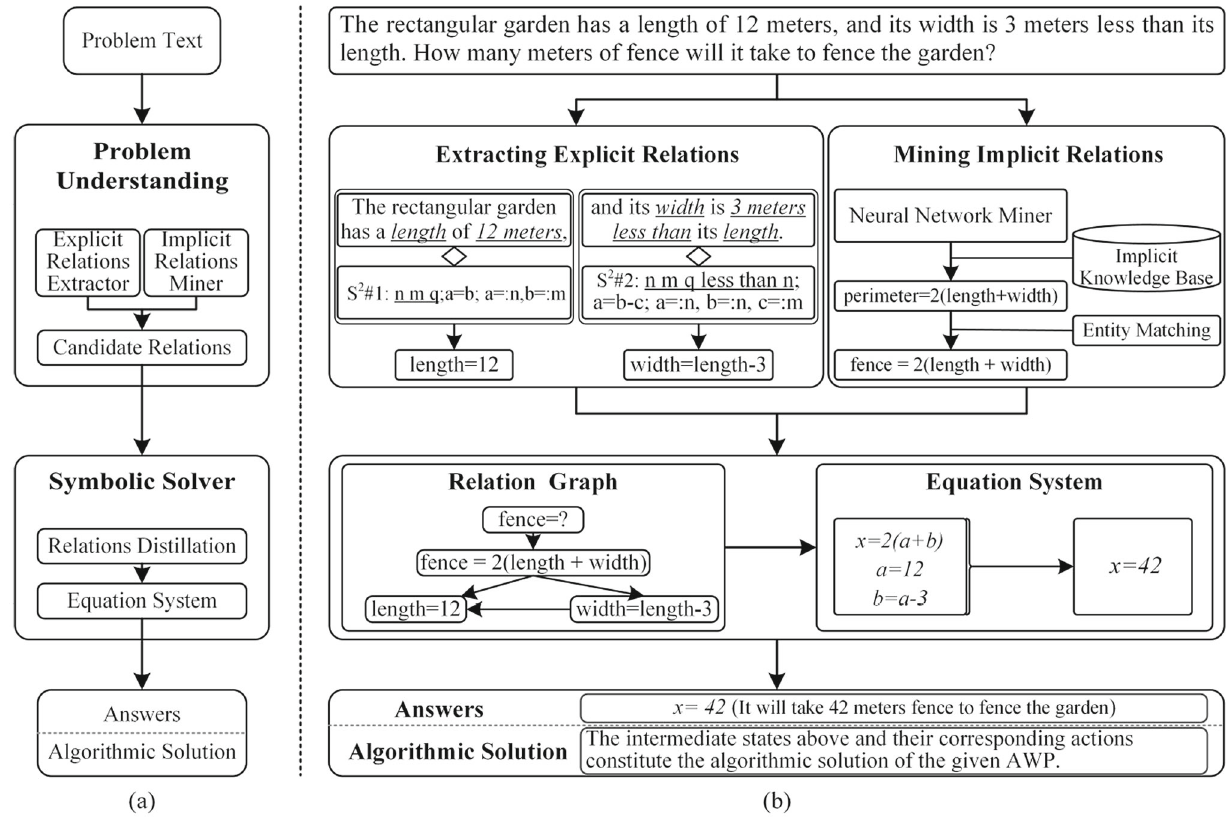
Fig.1 The pipeline of the proposed algorithm and the process that it solves the given AWP. The pipeline of the proposed relation-centric algorithm is in (a) ; the process that the proposed algorithm solves the given AWP is in